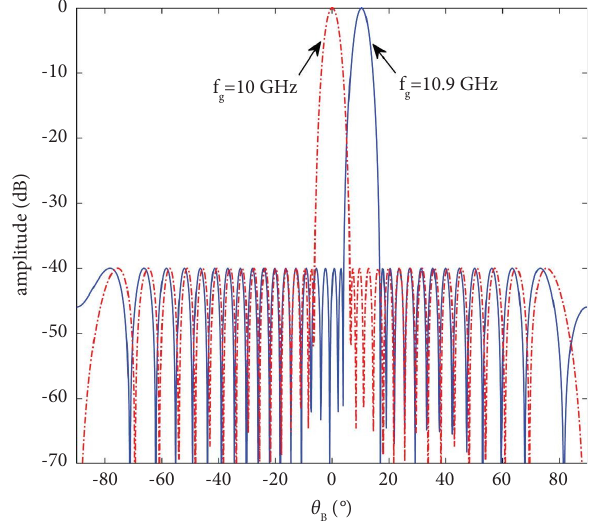
Figure 6: Beam pattern of the frequency scanning array